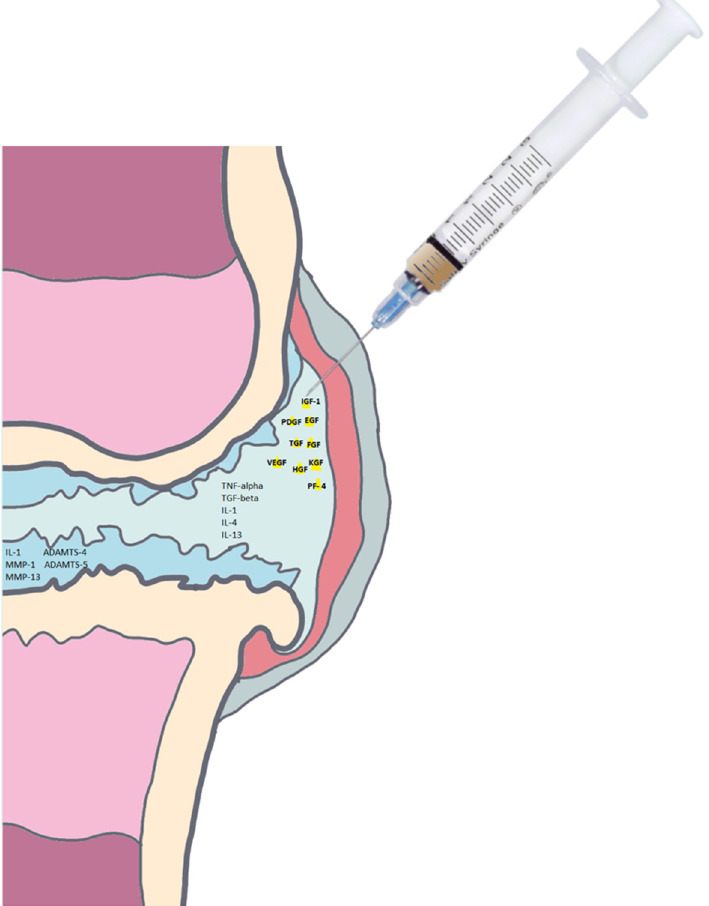
Figure 1. Growth factors (yellow triangles) released in the OA knee joint after PRP injection. TNF- tumor necrosis factor, IGF-insulin-like growth factor, TGF-transforming growth factor. VEGF-vascular endothelial growth factor, ADAMTS-a disintegrin and metalloproteinase with thrombospondin-like motifs, IL-interleukin, MMP-matrix metalloproteinase, EGF-epidermal growth factor, HGF-hepatocyte growth factor, FGF-fibroblast growth factor, KGF-keratinocyte growth factor, PF-4-platelet factor 4.